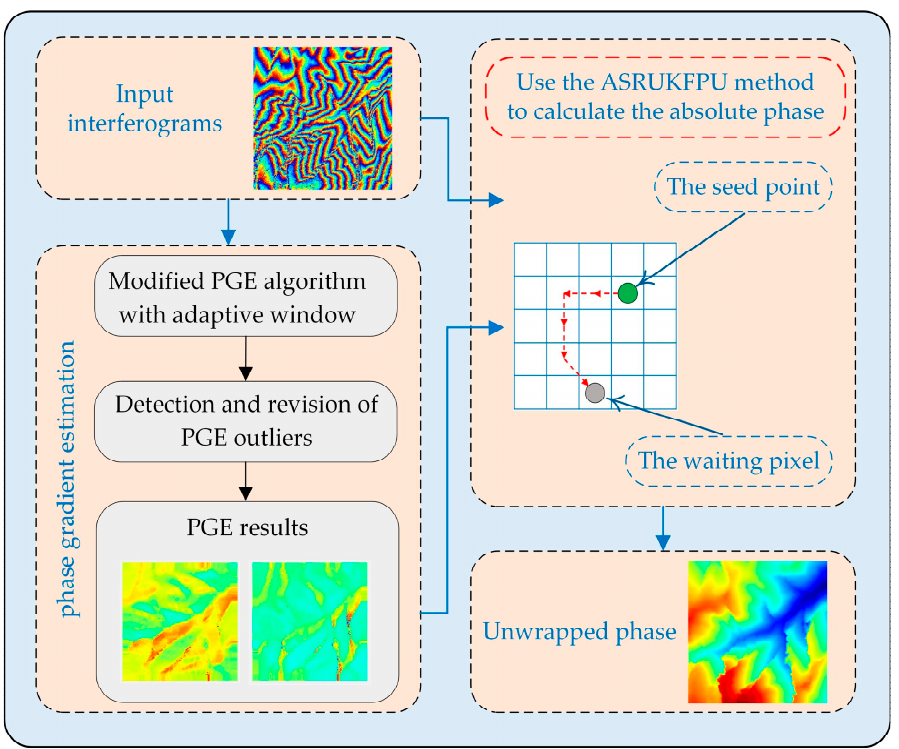
Figure 2. Schematic representation of the proposed adaptive square-root unscented Kalman filter phase unwrapping (ASRUKFPU) with modified phase gradient estimation method.